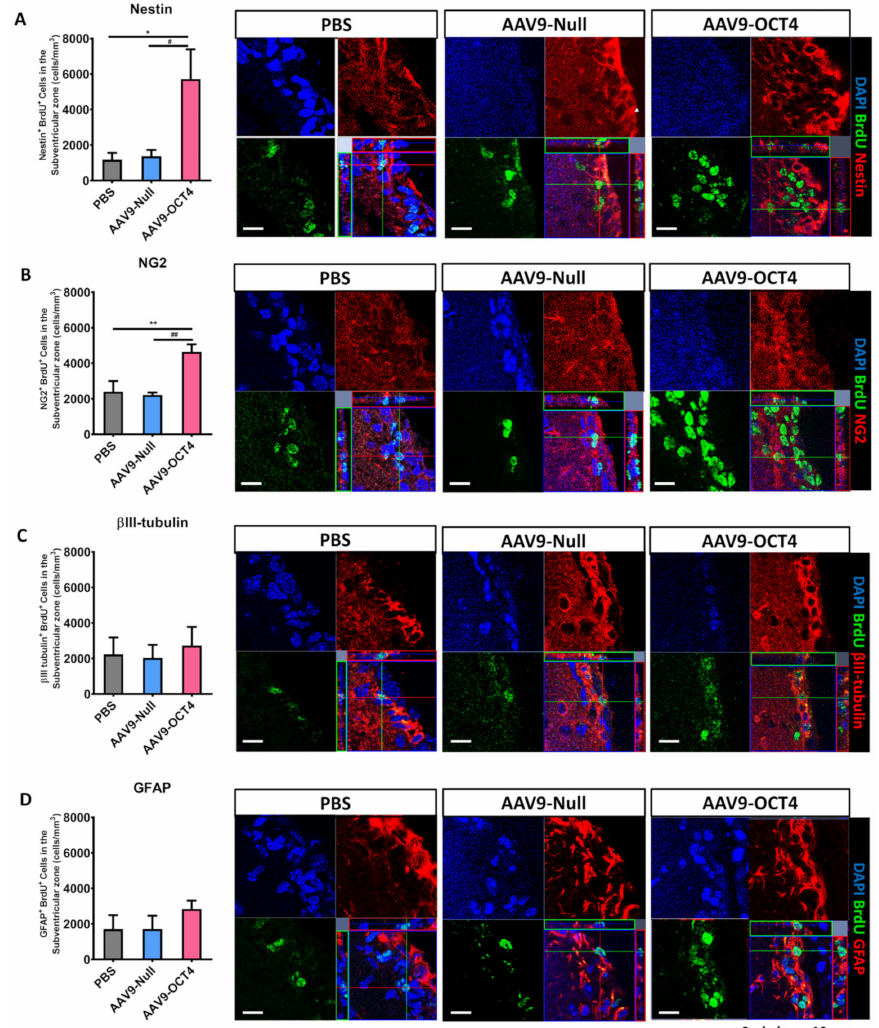
Figure 3. In situ expression of OCT4 increases OPCs in the SVZ. To confirm that OPC-related genes proliferation in the SVZ among three groups 2 weeks after stereotaxic injection by using confocal microscopy. ( A ) The numbers of Nestin + BrdU + (F = 5.947, * p = 0.024; # p = 0.041) and ( B ) NG2 + BrdU + cells were significantly higher in the AAV9-OCT4 group than control groups (F = 9.325, ** p = 0.008; ## p = 0.006), whereas ( C ) the numbers of β III-tubulin + BrdU + ( D ) and GFAP + BrdU + cells did not significantly differ among the three groups. *,# p < 0.05, Data in all panels represent mean ± SEM. *PBS vs. AAV9-OCT4, #AAV9-Null vs. AAV9-OCT4. PBS group (N = 3); AAV9-Null (N = 3); AAV9- OCT4 (N =